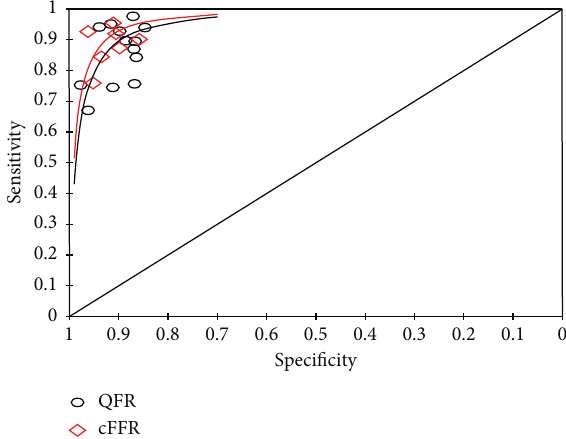
Figure 4: Summary receiver-operating characteristic curve for cFFR and